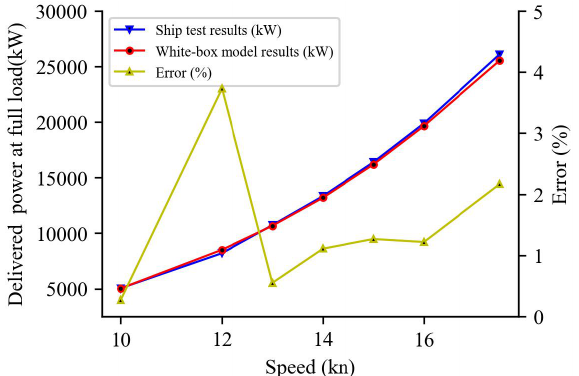
Figure 11. Still water resistance delivered power at full